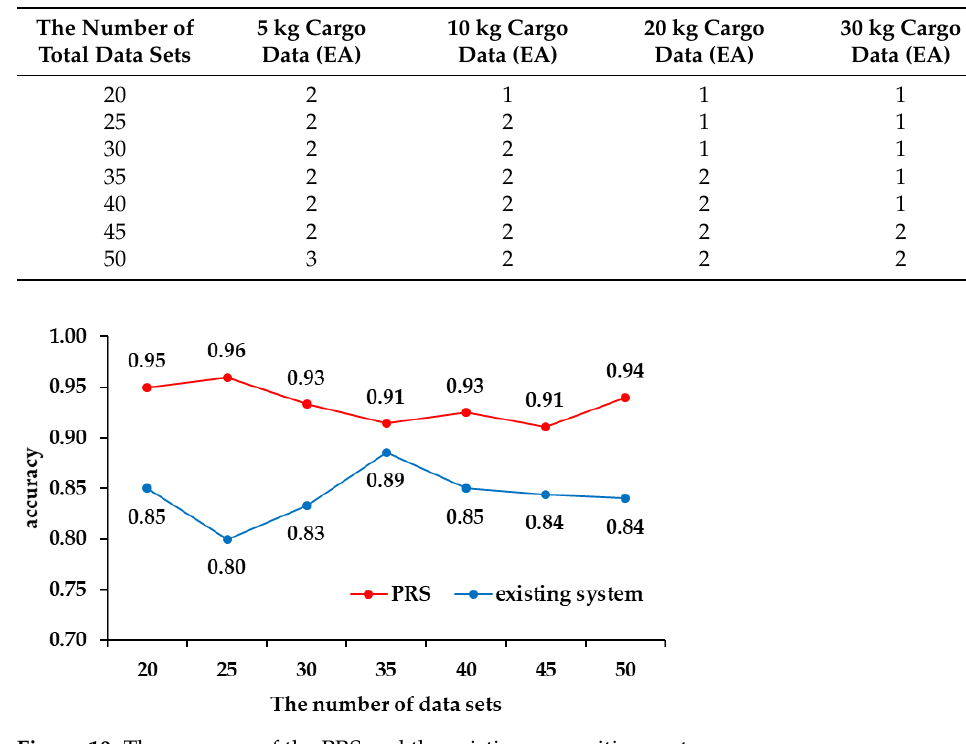
Figure 10. The accuracy of the PRS and the existing recognition system.